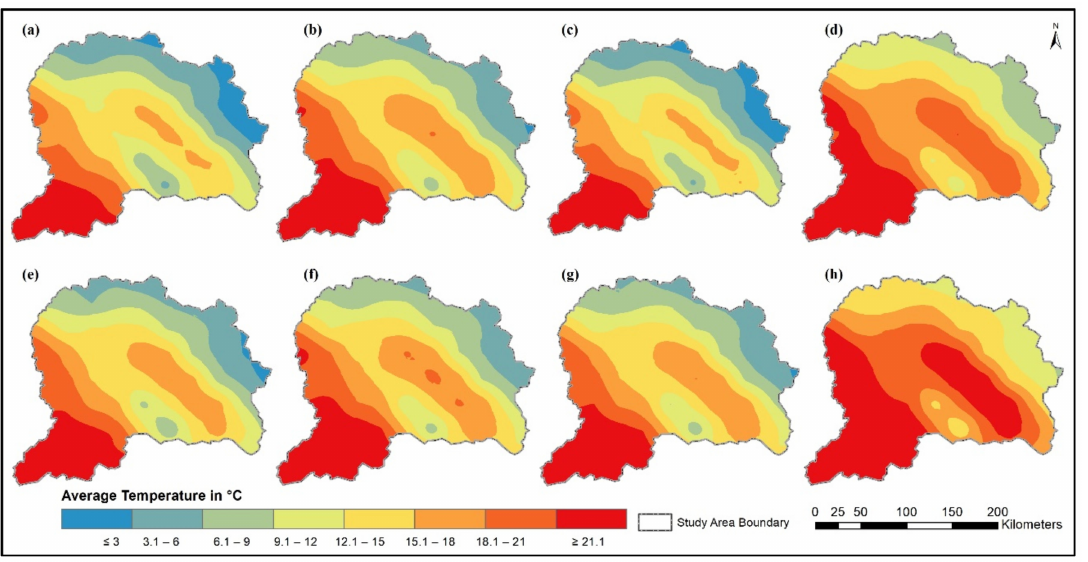
Figure 5. Spatial projections of average temperature ( ◦ C): ( a ) CCSM4 RCP-4.5 2021–2060; ( b )